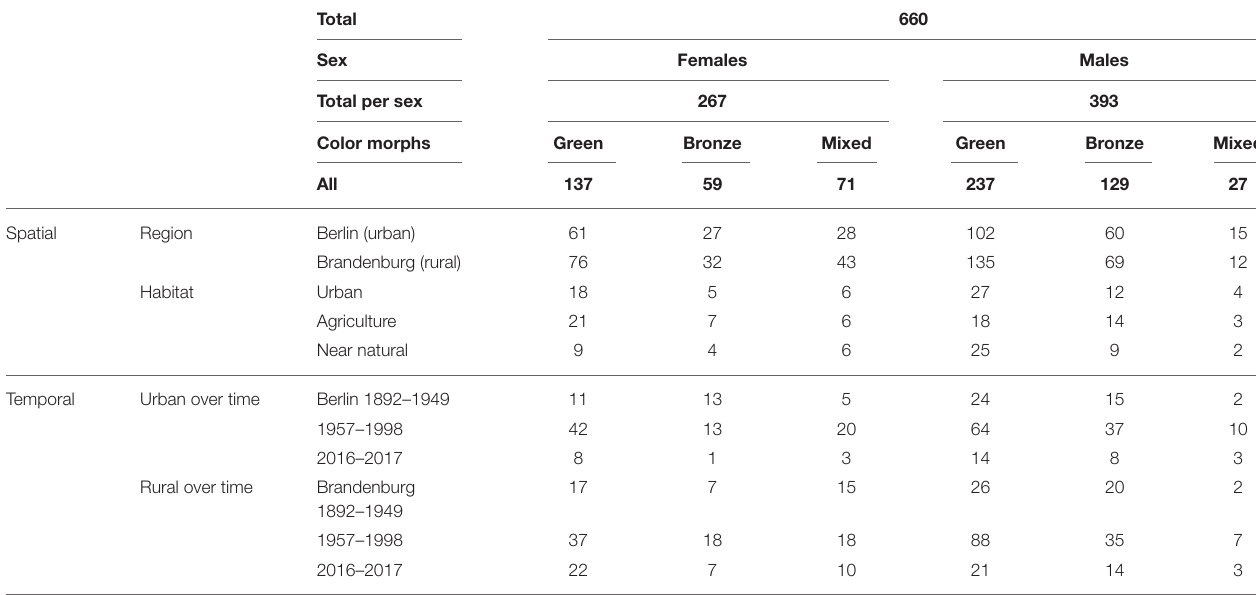
TABLE 1 | Total number of Harpalus affinis investigated for this